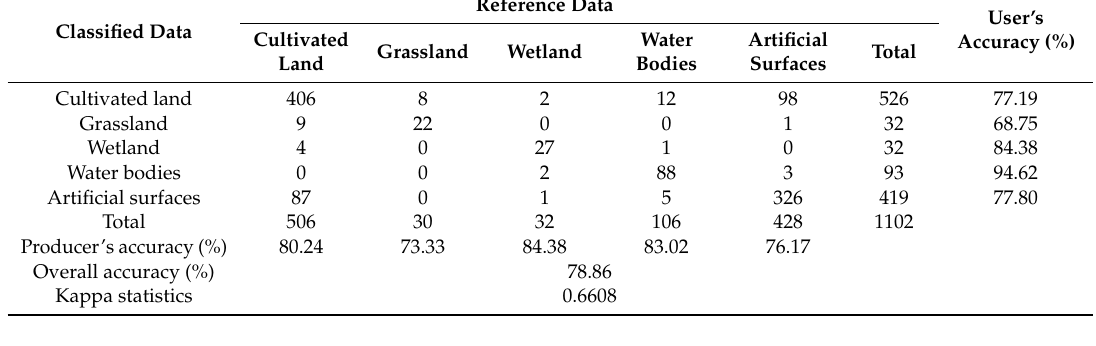
Table 5. Error matrix and classification accuracy for ECVA_OB + SVM.